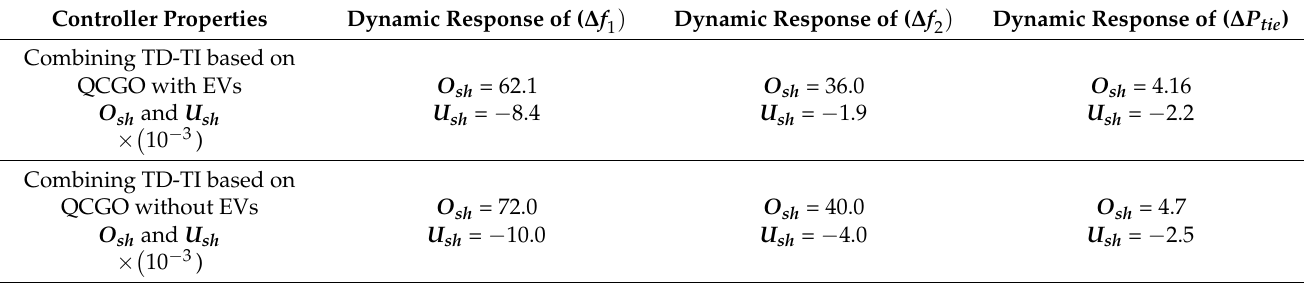
Table 22. The transient response specifications of the presented system for case D.